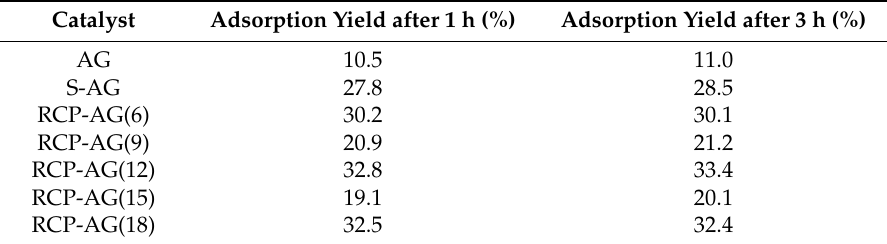
Table 3. Summary of adsorption yield in